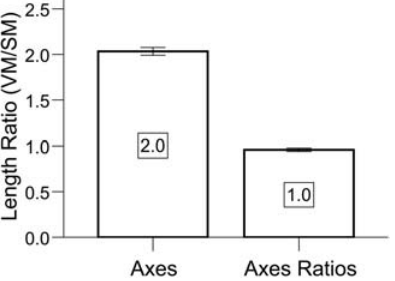
Figure 3. Validation of Processing Pathway. The stereolithographic model preserved the VM:SM average axes scaling factor of 2:1 [Mean + / 2 SEM=2.03 + / 2 0.04; t(2)=0.79;p=0.51, 2-tailed] and the 1:1 average axes proportion [Mean + / 2 SEM=0.96 + / 2 0.02; t(2)= 2 2.2;p=0.16, 2- tailed]. Error bars are SEM.